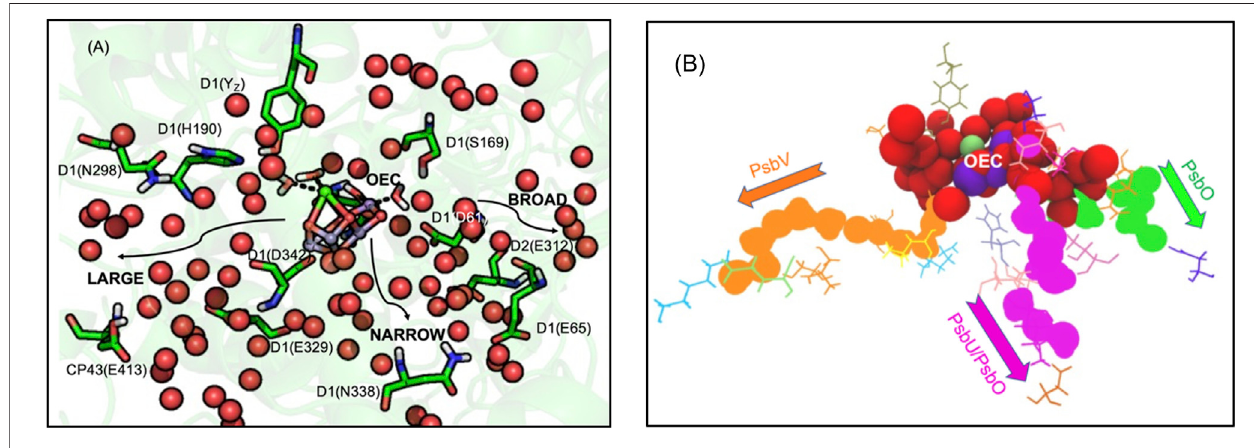
FIGURE4|(A,B) . (A) Water channels aroundthe Oxygen EvolvingComplex(OEC) ofPSII.Water spheres (red) and amino acidresidues highlighting thedirections toward the large, broad and narrow channels (Vassiliev et al., 2012; Vogt et al., 2015). The notation for each residue is subunit-residue type, number. Residues in large channel: Y Z , D1-H190, N298, E329, D342 (OEC primary ligand), CP43-E413. Narrow channel: D1-S169, N338. Broad channel: D1-D61, E65, D2-E312. (B) Waters extendingfromtheOECtotheN-sidelumen.Redspheresshowhighlyinterconnectedwatermoleculesextending ≈ 10 ÅfromtheOEC.Thestructurethenresolves to form three separated water fi lled channels: large (orange), narrow (magenta) and broad (green). Large channel extends from O1 of OEC to PsbV, narrow channel extendsfrom O4toPsbU/PsbOwhile broad channel extends fromO5toPsbO. See Supplementary Figure S1 for amore detailed view ofthe OEC.Coordinatesfrom one MD snapshot initiated from Thermosynechococcus vulcanus PDB ID: 4UB6.